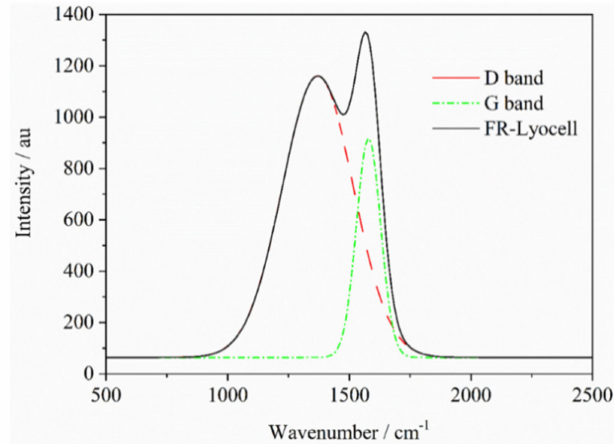
Figure 11. Raman spectra of the char residues of FR − lyocell